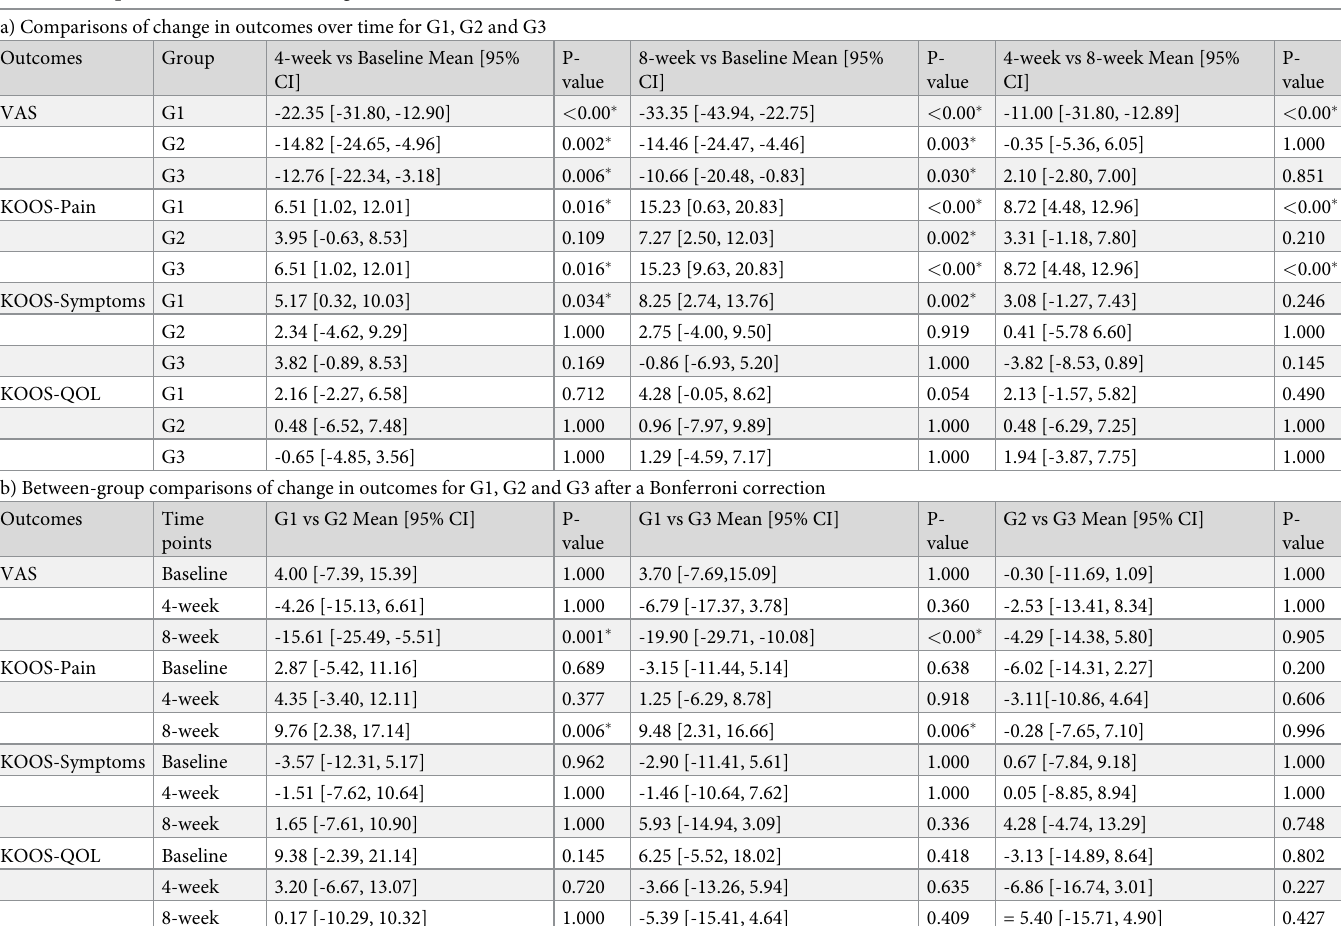
Table 2. Comparisons of outcomes among G1, G2 and G3 after a Bonferroni correction. a) Comparisons of change in outcomes over time for G1, G2 and G3